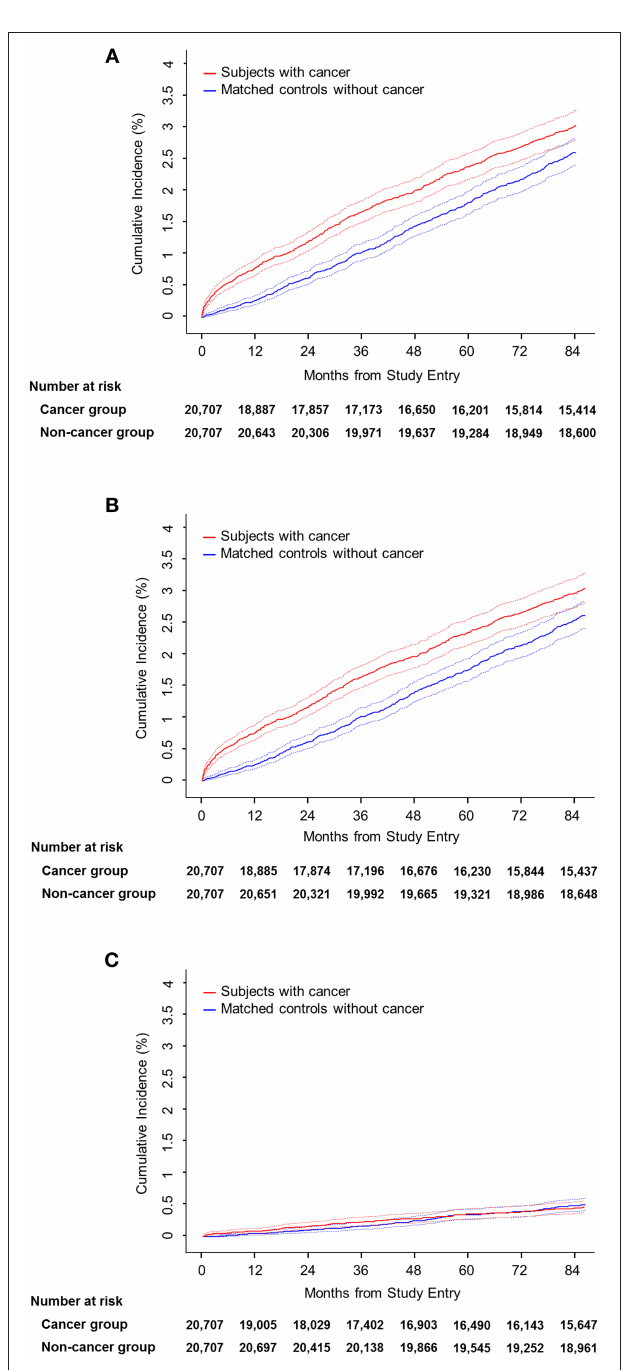
FIGURE 2 | Cumulative incidence by stroke subtype. (A) Any stroke. (B) Ischemic stroke. (C) Hemorrhagic